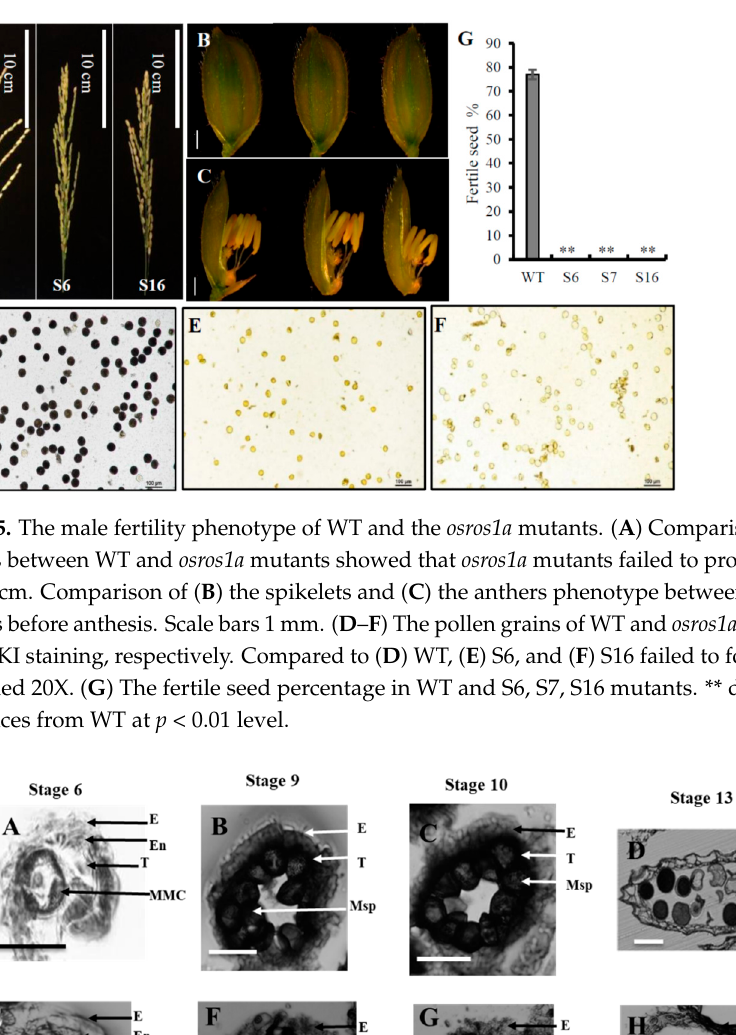
Figure 5. The male fertility phenotype of WT and the osros1a mutants. ( A ) Comparison of the mature panicles between WT and osros1a mutants showed that osros1a mutants failed to produce seeds. Scale bars 10 cm. Comparison of ( B ) the spikelets and ( C ) the anthers phenotype between WT and osros1a mutants before anthesis. Scale bars 1 mm. ( D – F ) The pollen grains of WT and osros1a mutants staining with I 2 -KI staining, respectively. Compared to ( D ) WT, ( E ) S6, and ( F ) S16 failed to form viable pollen. Magnified 20X. ( G ) The fertile seed percentage in WT and S6, S7, S16 mutants. ** denote significant differences from WT at p < 0.01 level.